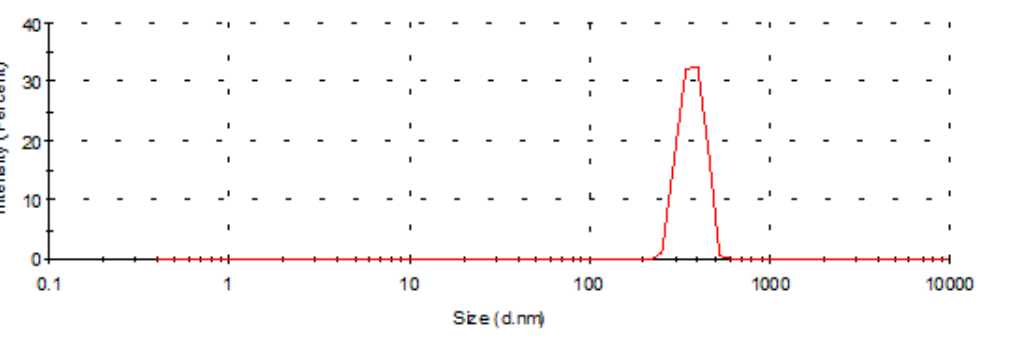
Figure 4. Graph representing particle size distribution of EBZ-loaded niosomes.